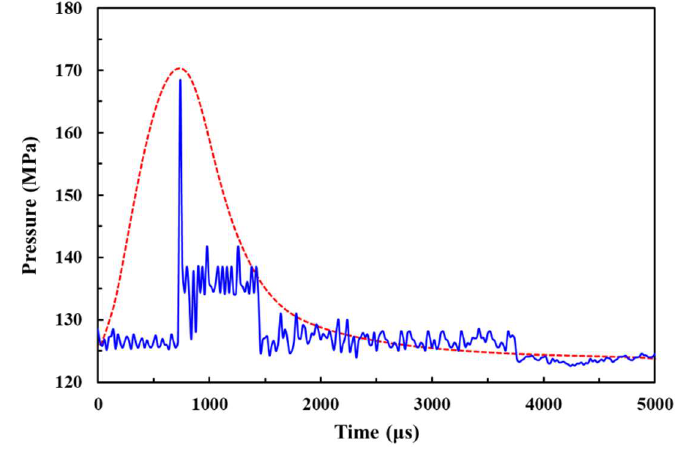
Figure 7. Wellbore bottom pressure-time curves.